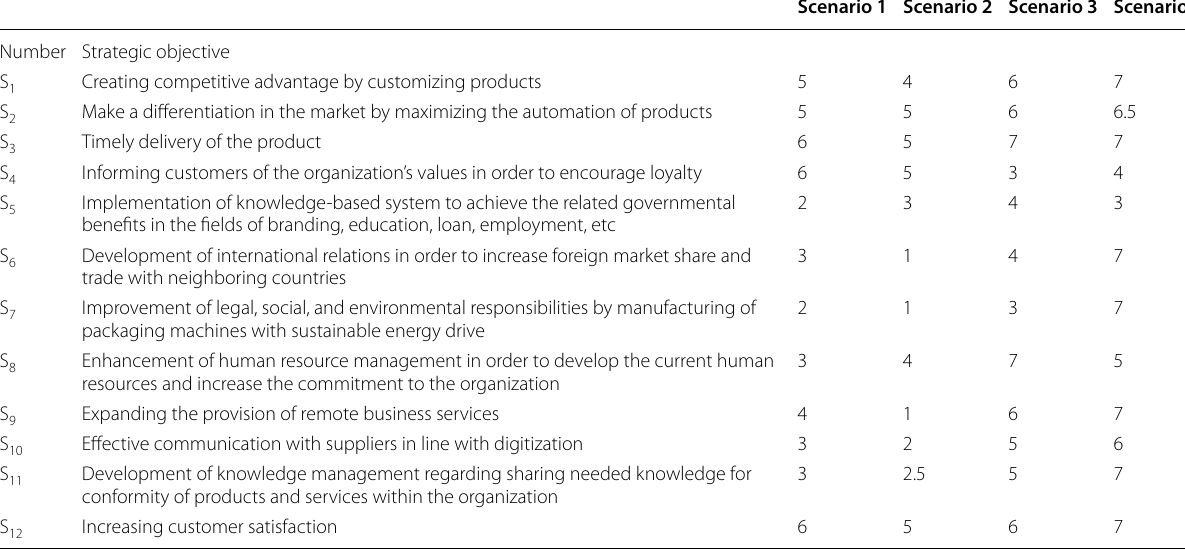
Table 7 The list of preexisting strategic objectives extracted from the Iranian SME’s strategic